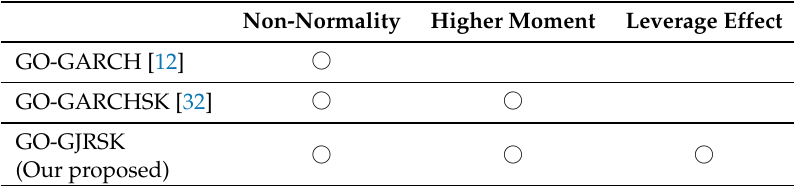
Table 1. Comparison between our proposed and the models of related